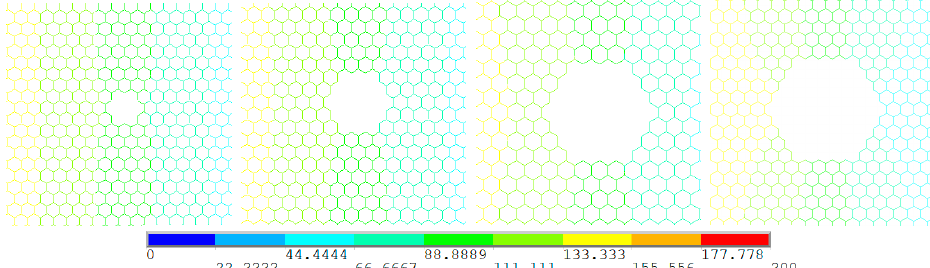
Figure 7. Temperatures in the local region around the center concentrated vacancy with its heat source in armchair edges.